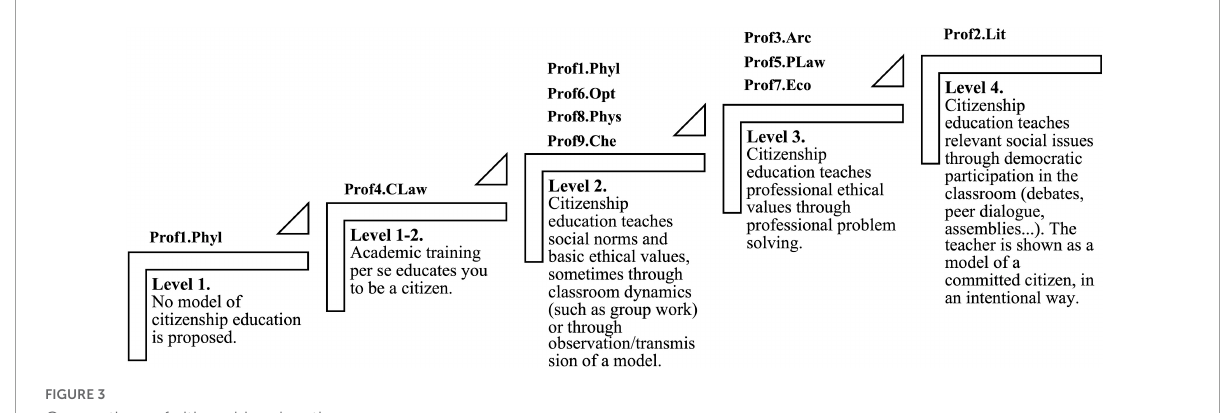
FIGURE3 Conceptions of citizenship